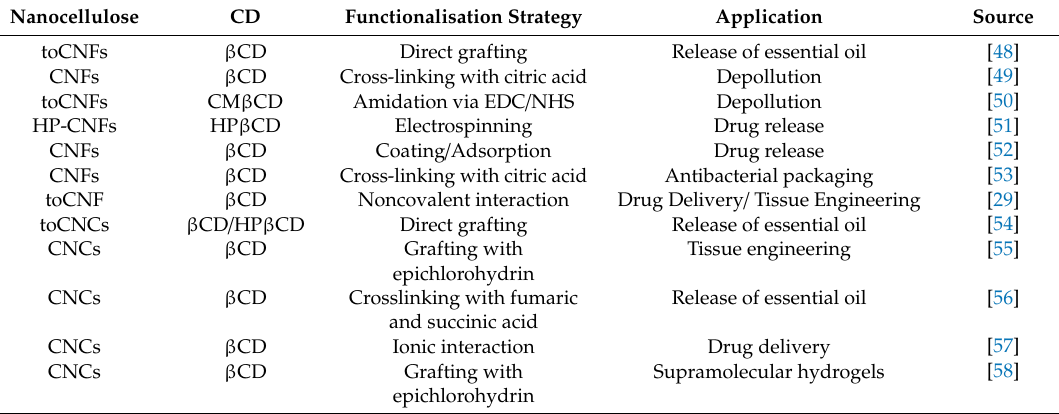
Table 1. Previous works on the association nanocellulose-cyclodextrin. CNFs: cellulose nanofibrils, toCNFs: TEMPO-oxidised cellulose nanofibrils, HP-CNFs: hydroxypropyl cellulose nanofibrils, CNCs: cellulose nanocrystals, β CD: β -cyclodextrin, CM β CD: carboxymethyl- β -cyclodextrin, HP β CD: hydroxypropyl- β